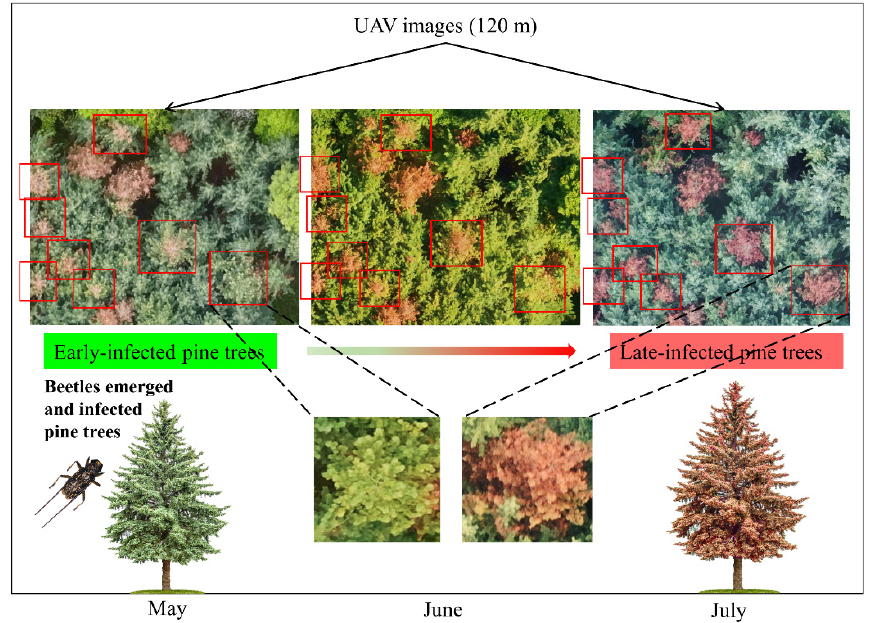
Figure 8. UAV images of pine trees from the early (May) to the late stage (July) of PWD